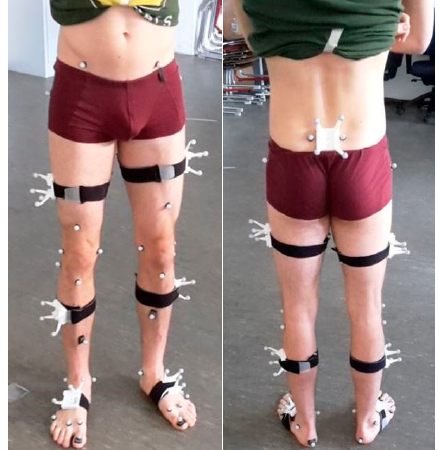
Figure 1. Instrumentation of one exemplary subject. Marker set and rigid marker clusters.